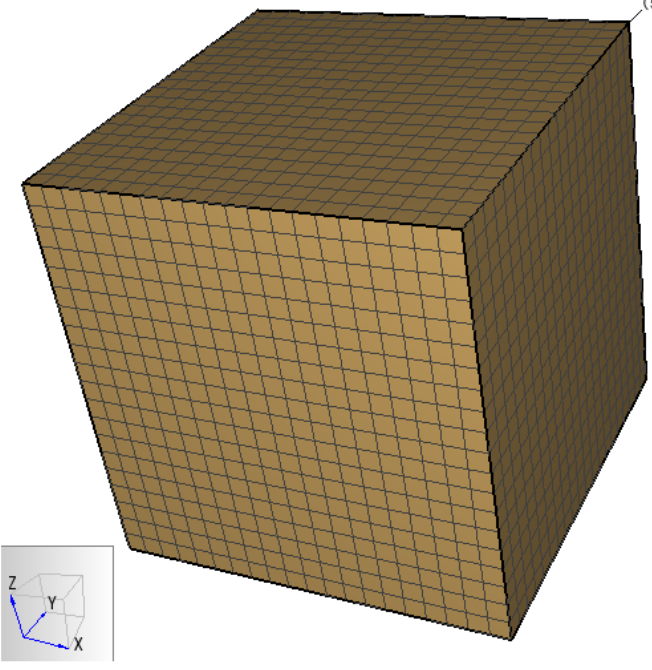
Figure 3. The simulated domain and three-dimension grid for the vertical well system.